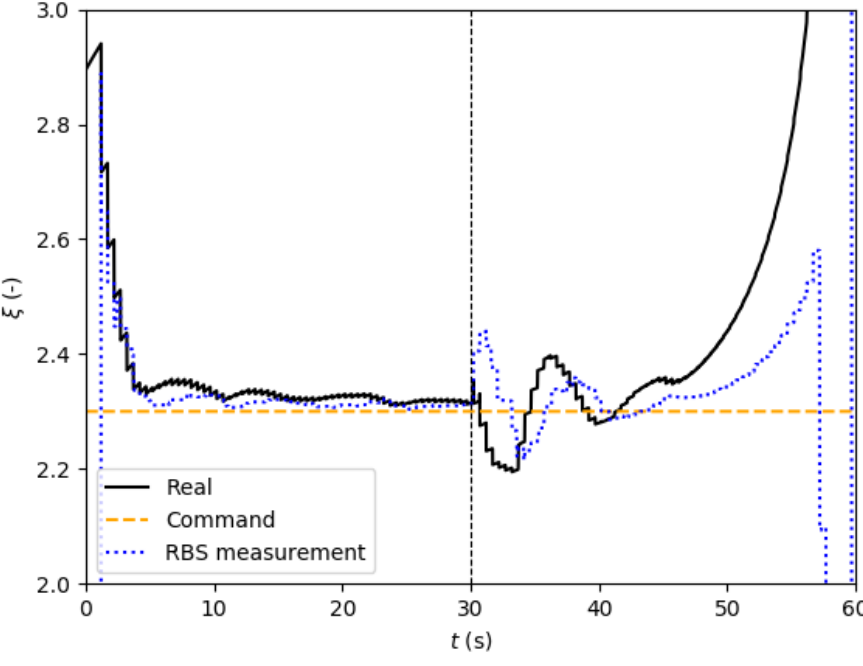
Figure 22. Mixture ratio profile, feedback with complete regulation law, case 2.